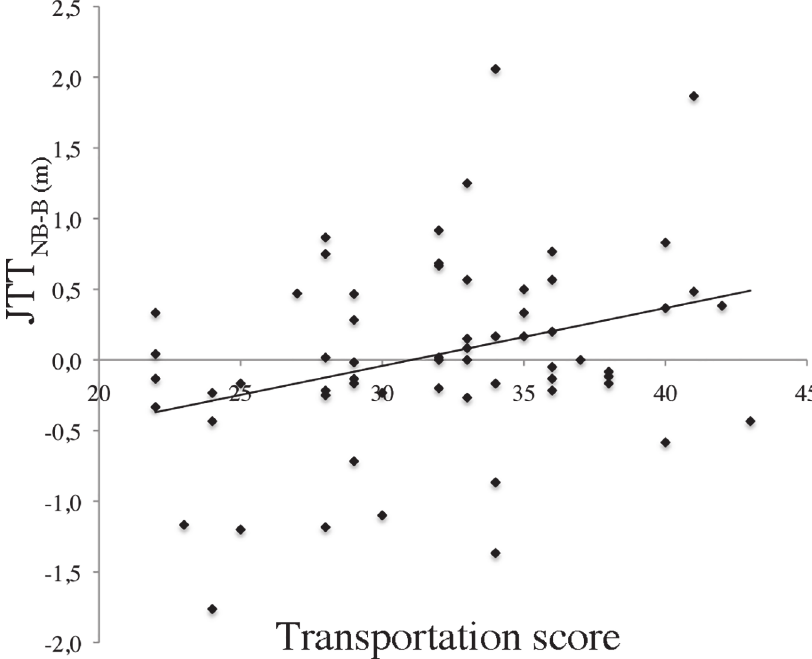
Fig 2. Significant correlation between the JTT NB-B index and the questionnaire transportation score.